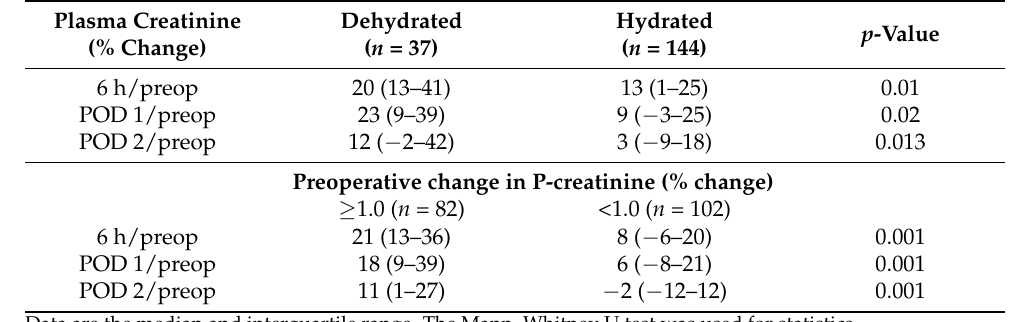
Table 5. Statistical comparison between postoperative plasma creatinine relative to the preoperative concentration, depending on the presence of dehydration (as indicated by a preoperative urine sample) and whether plasma creatinine increased or decreased during the preoperative period.